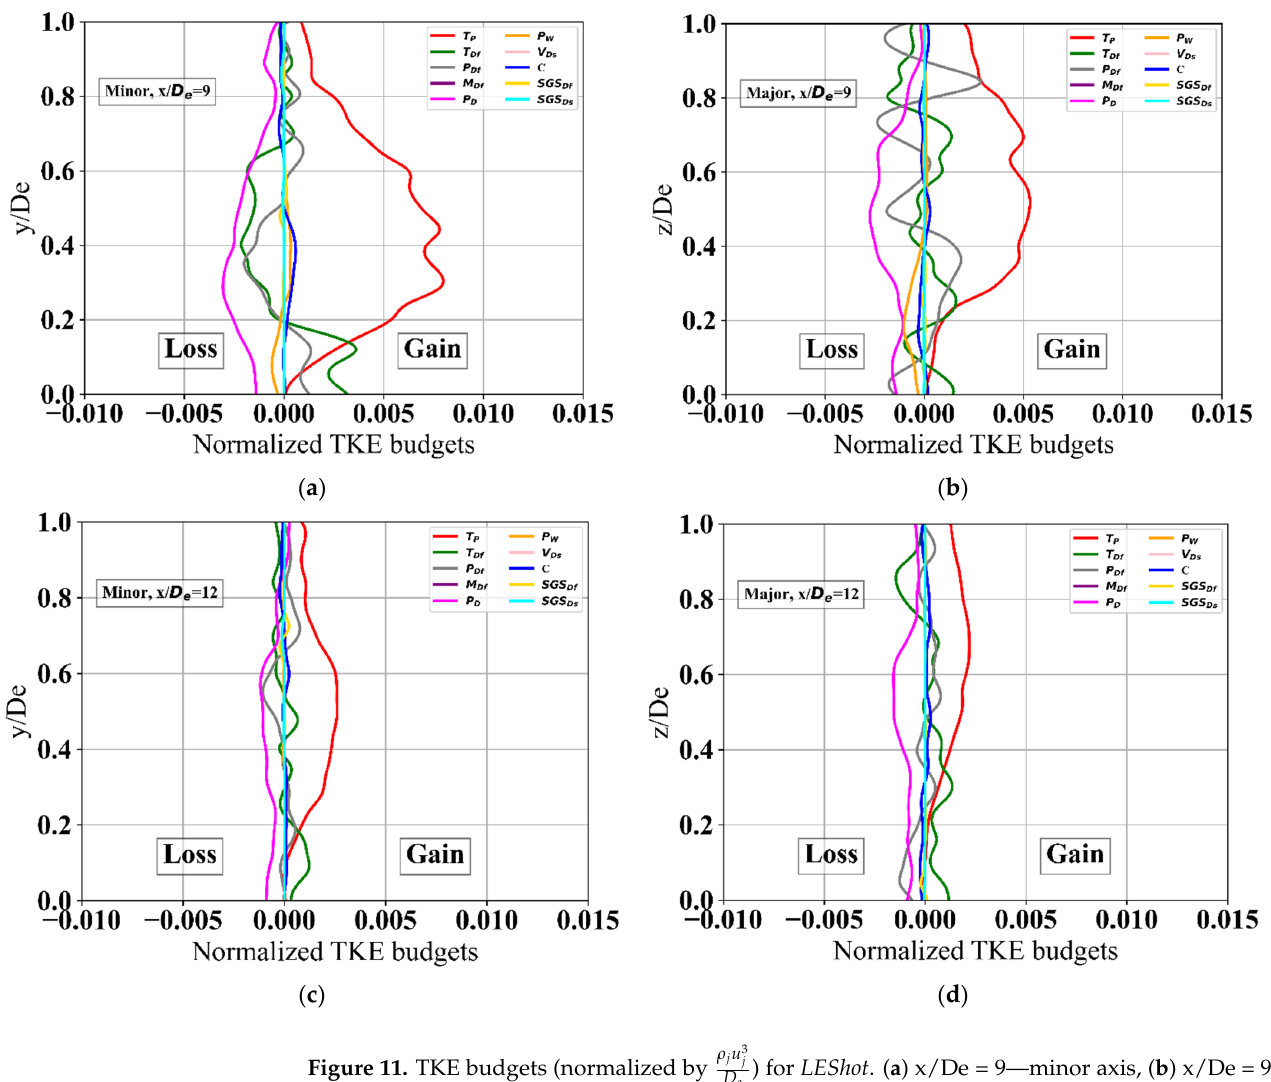
Figure 11. TKE budgets (normalized by major axis, ( c ) x/De = 12—minor axis, ( d ) x/De = 12—major axis.